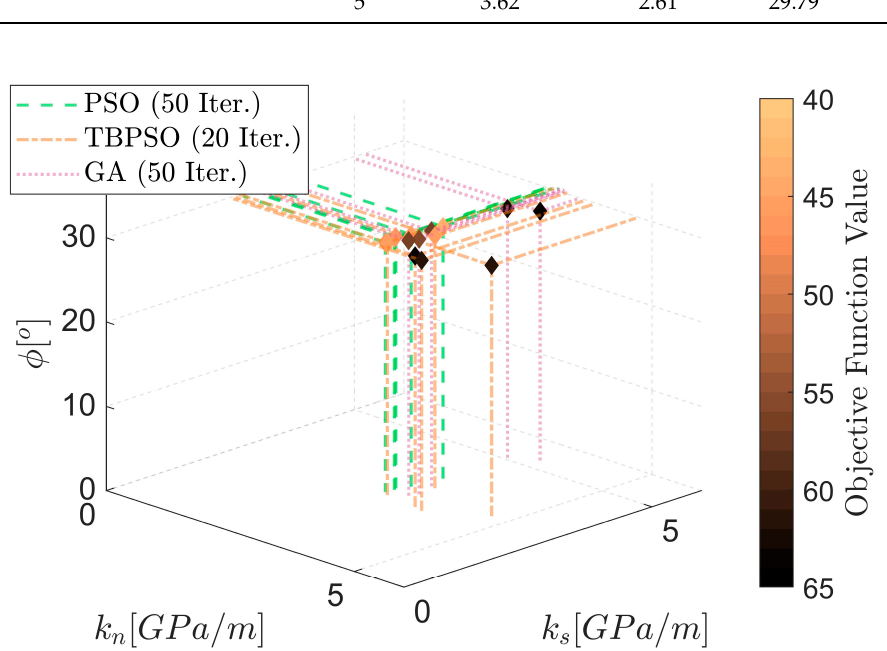
Figure 14. Position of calibrated material parameters of Pulatsu’s geometry (objective function 1 PSO and GA: 50 iterations; TBPSO: 20 iterations). Table 1 . Five best solution sets for objective function 1 of Pulatsu’s geometry.